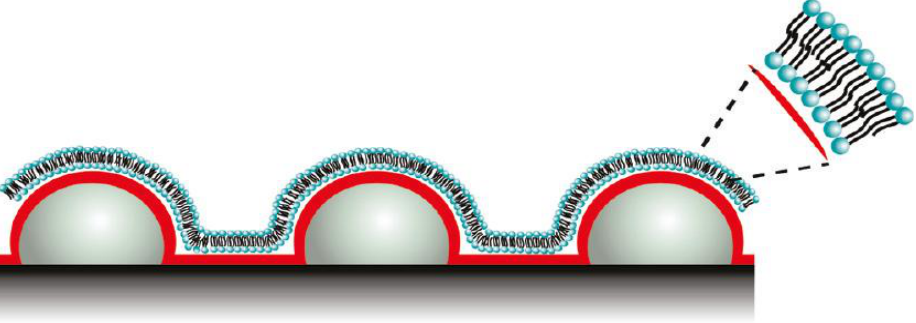
Figure 6. Schematic representation of lipid bilayers used for protein binding. Reprinted with permission from [45], © 2011 American Chemical Society.